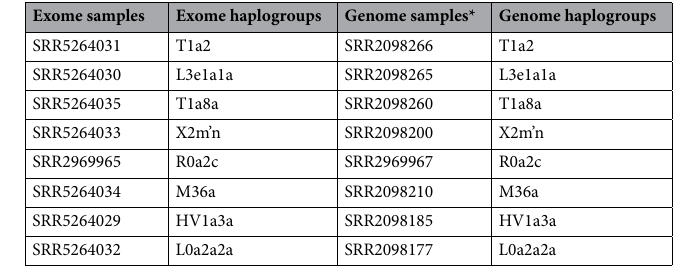
Exome samples Exome haplogroups Genome samples* Genome